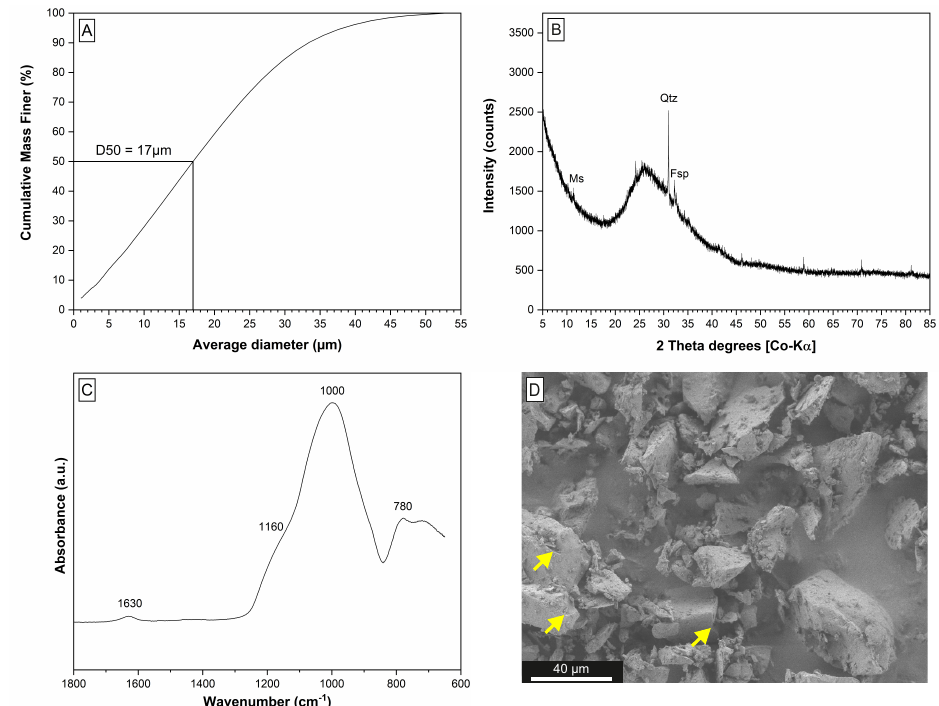
Figure 2. Characterization of the perlite powder used for zeolite synthesis. ( A ) The particle size distribution curve shows the perlite has a grain size of <55 µm and a median diameter (d50) of 17 µm. ( B , C ) The XRD pattern and the FTIR spectrum reveal the dominance of an amorphous phase and minor muscovite, quartz, and feldspar in the perlite powder. ( D ) The electron microscope image identifies the amorphous phase as volcanic glass shards, which show conchoidal fractures (marked by the yellow